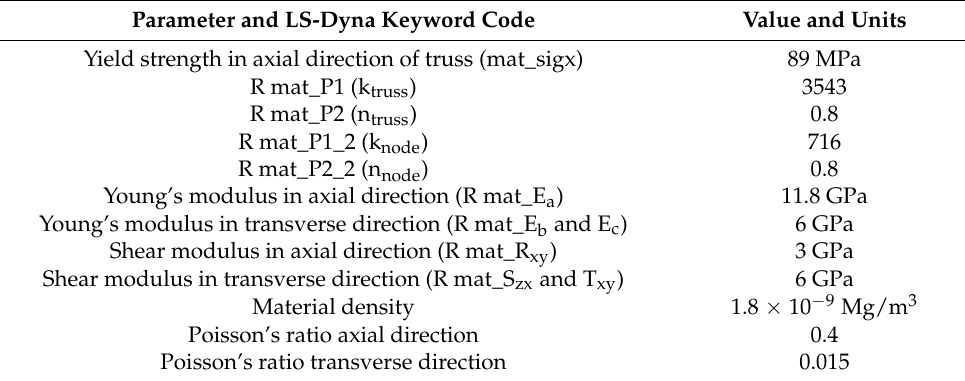
Table 2. Material properties used in LS-Dyna for numerical simulation using material 122_3D. Parameter and LS-Dyna Keyword Code